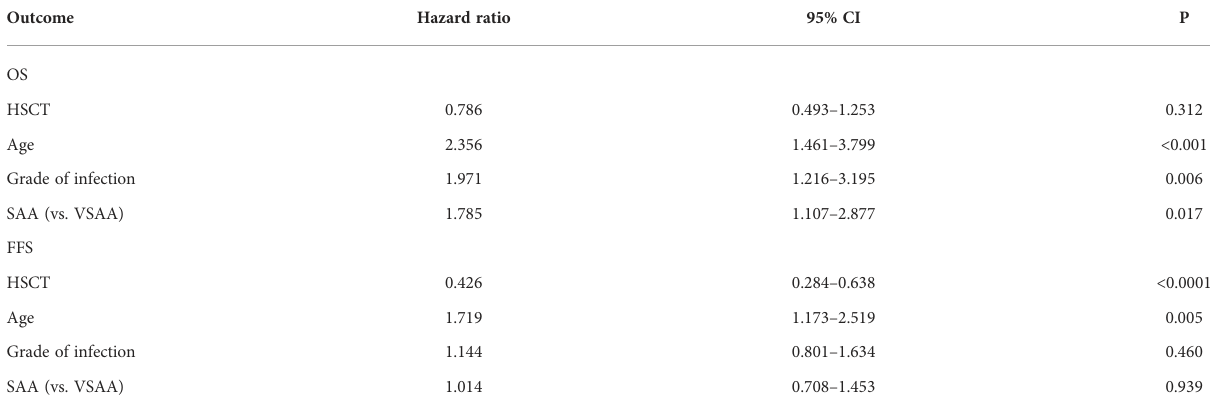
TABLE 4 Multivariate analysis of favorable factors associated with OS and